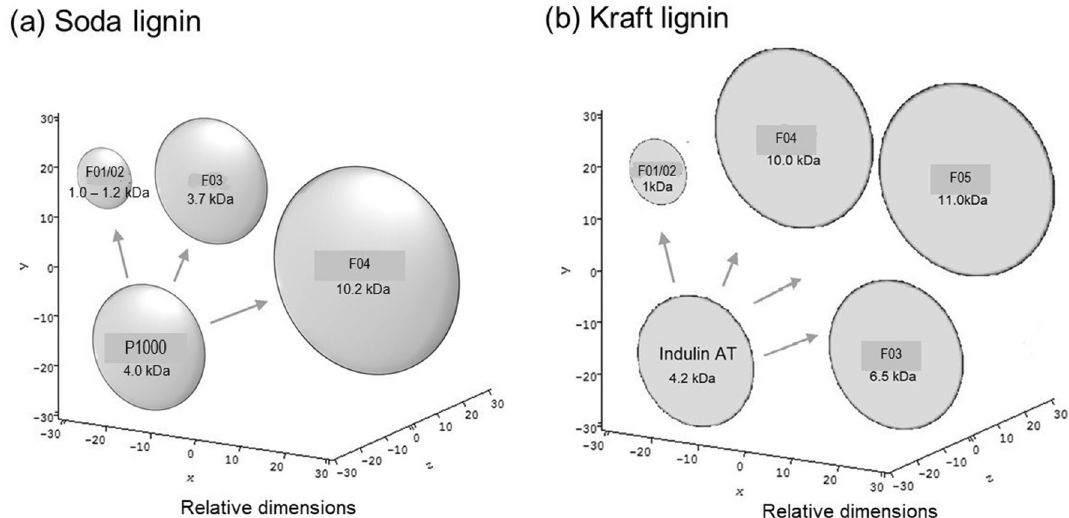
Figure 3. Relative sizes, depicted as oblate ellipsoids 44,57 of ( a ) P1000 soda and ( b ) Indulin AT Kraft lignins and solvent-extracted fractions. Untreated P1000 soda and untreated Indulin AT Kraft lignins are shown; F01, ethyl acetate fraction; F02, methyl ethyl ketone fraction; F03, methanol fraction; F04, acetone:water (4:1) fraction; and F05,